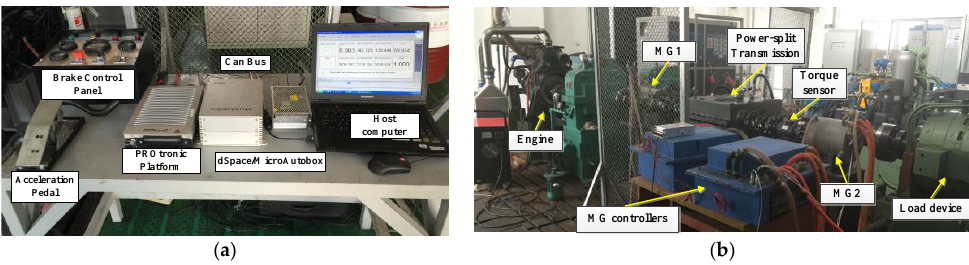
Figure 17. Bench test for the hybrid HDV with PST: ( a ) data acquisition devices; and ( b ) bench test configuration.